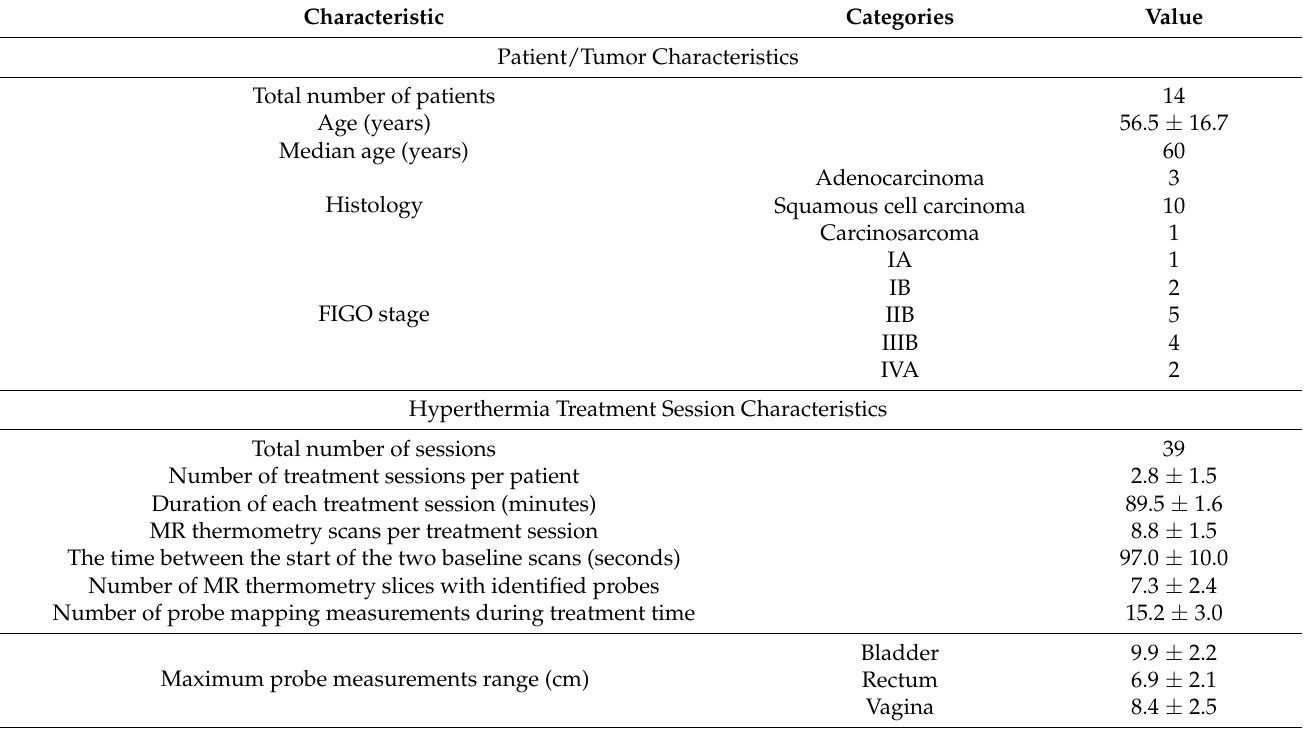
Table 1. Characterization of the data used in this study: patient and tumor characteristics, and hyperthermia treatment sessions characteristics. For continuous data, the age, total number of sessions, and values were expressed by the mean ± standard